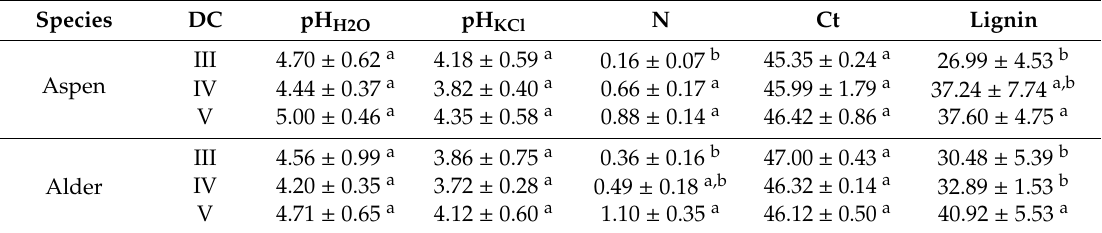
Table 2. Chemical properties of deadwood of di ff erent species in di ff erent decay